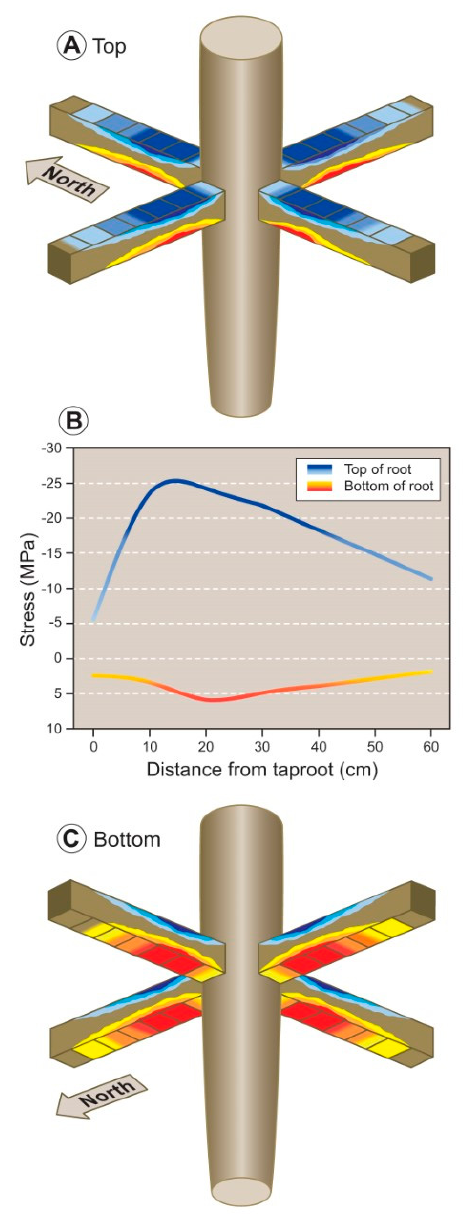
Figure 7. Model representing the distribution of mechanical forces along the top and bottom portion of four theoretical lateral roots extending in the four cardinal directions. Upper panel ( A ) shows the distribution of compression forces. The highest intensity of the blue color represents where the maximum compression force is present. The lower panel ( C ) shows the distribution of tension forces. The highest intensity of the red color represents where the maximum tension force is present. The theoretical lateral root is divided into 10 cm long blocks, extending from the branching point to the cage boundary. The central rod represents the taproot. Intermediate panel ( B ) indicates the distribution of theoretical compression and tension mechanical forces (MPa) on the upper (top of the root) and lower (bottom of the root) side of the lateral root along the distance from the branching point (cm).